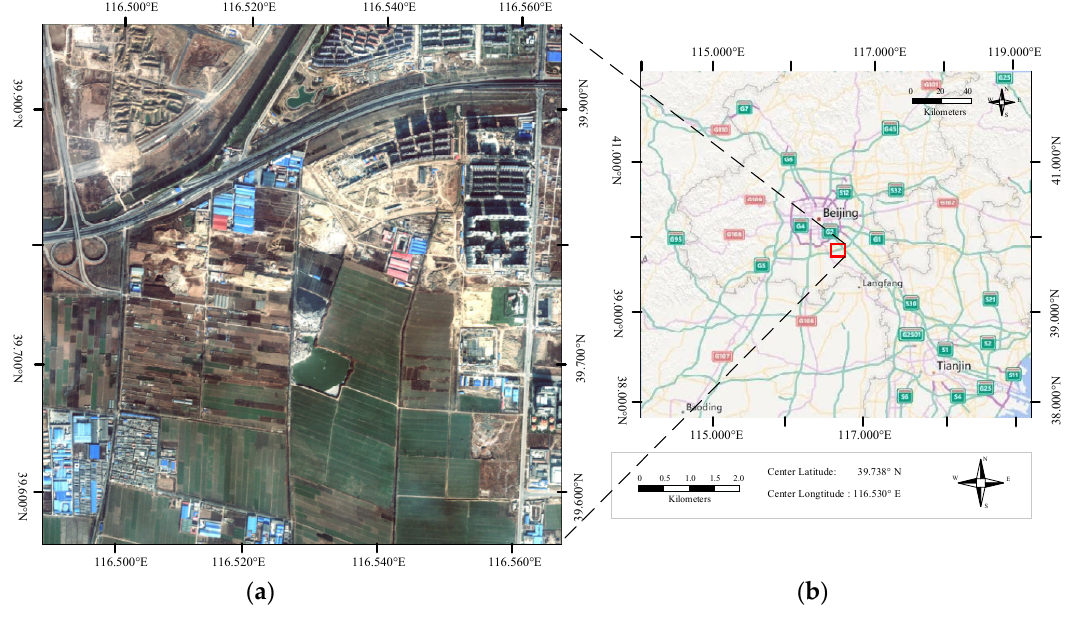
Figure 6. ( a ) The original image of Scene-TZ; ( b ) The geographic location of Scene-TZ.